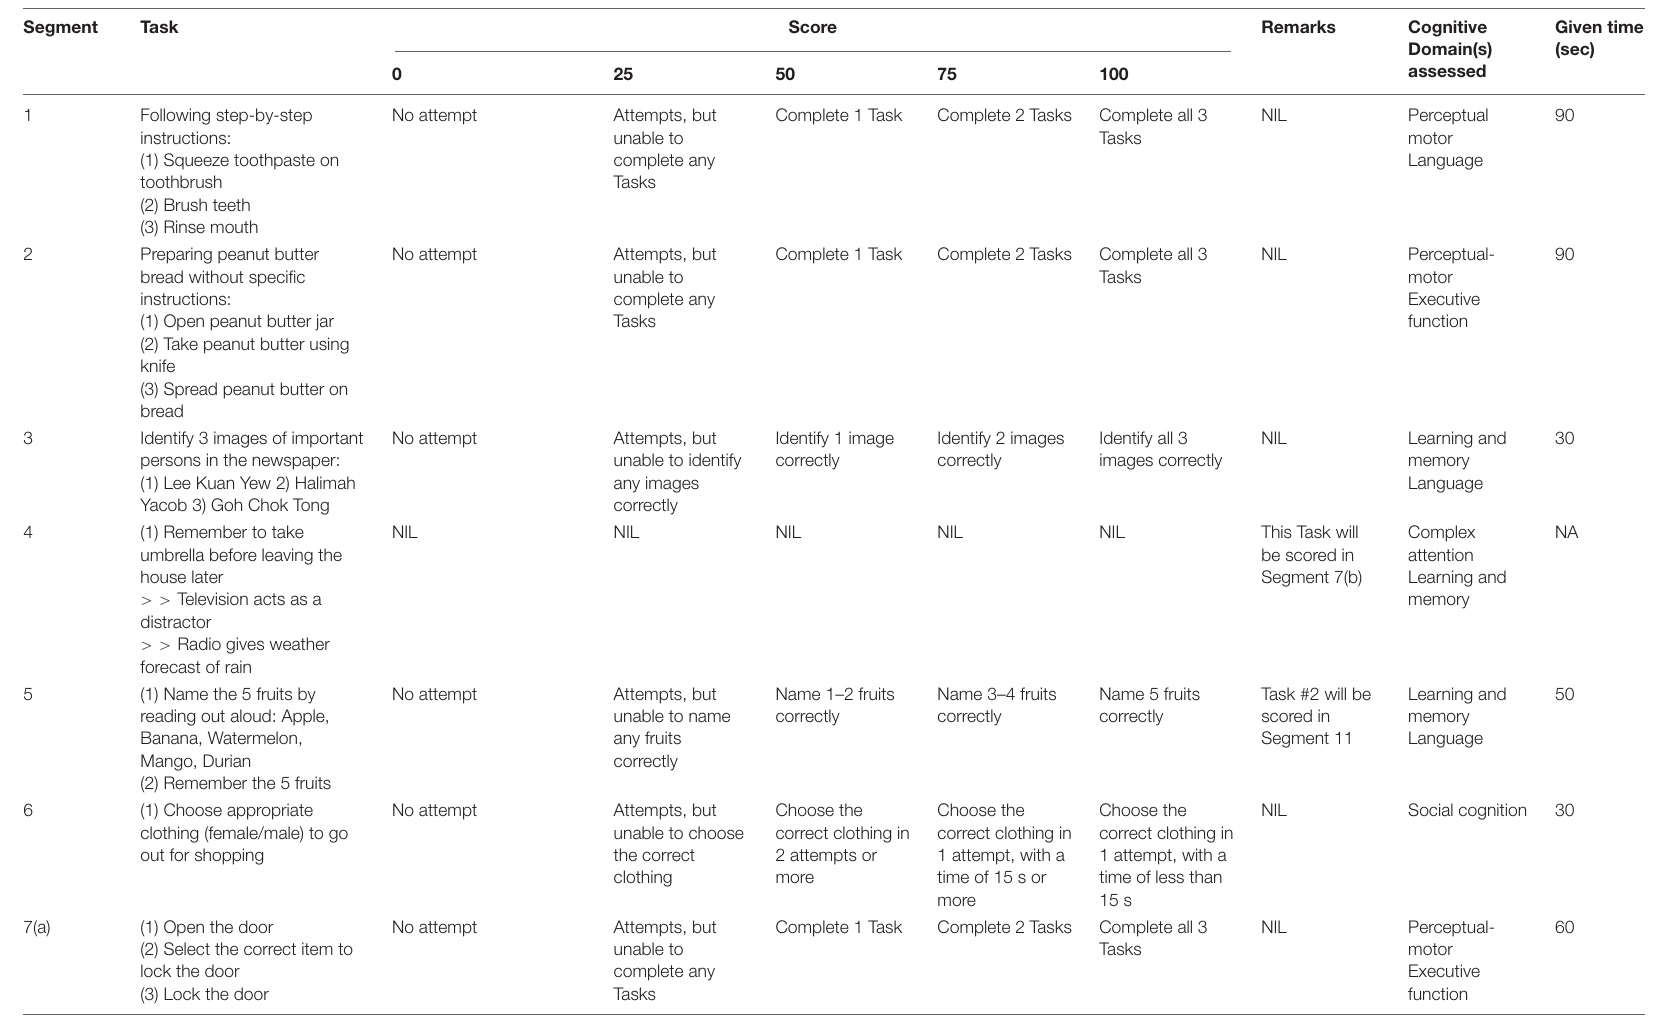
TABLE A1 | Scoring algorithm of the VR assessment.